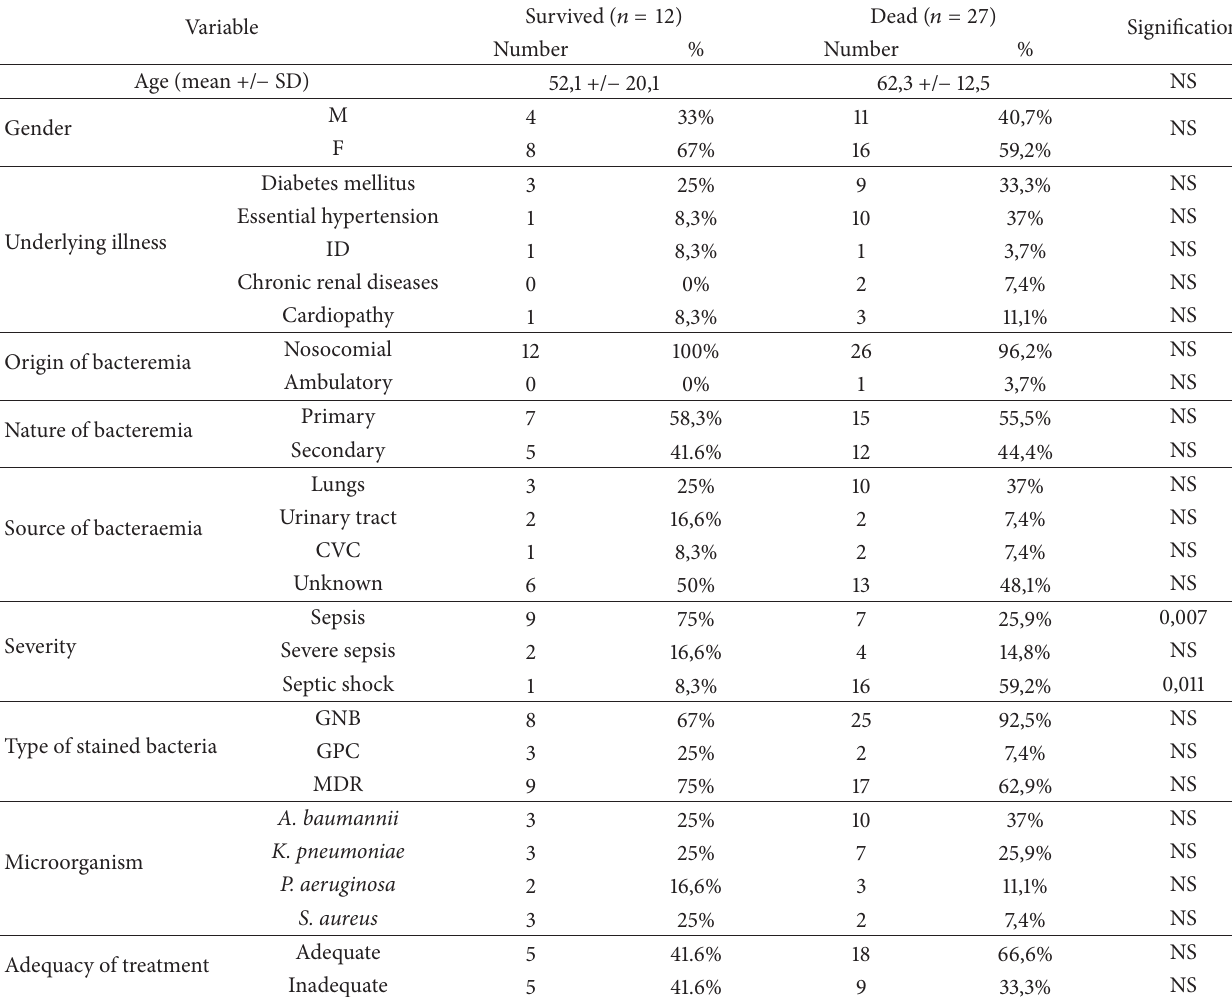
Table 5: Comparison between the dead and survived patients in the study based on demographic, clinical, and microbiological profiles.